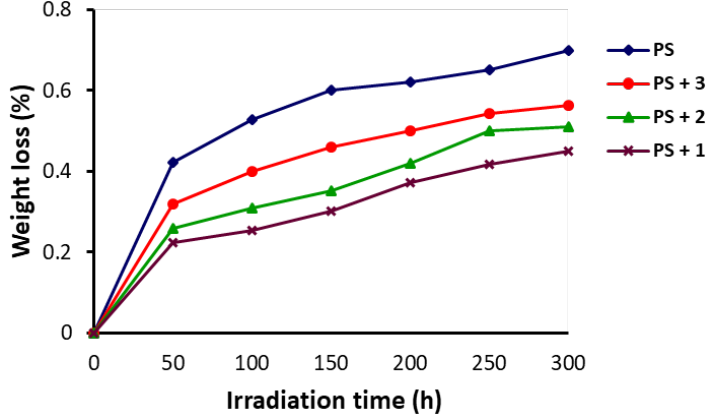
Figure 6. Changes in the weight of PS upon irradiation.